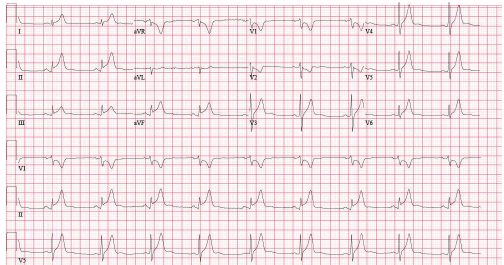
Figure 1: EKG showing sinus tachycardia, ST elevation in lead II, III, and aVF, and ST depression with T wave inversion in V1 and V2.